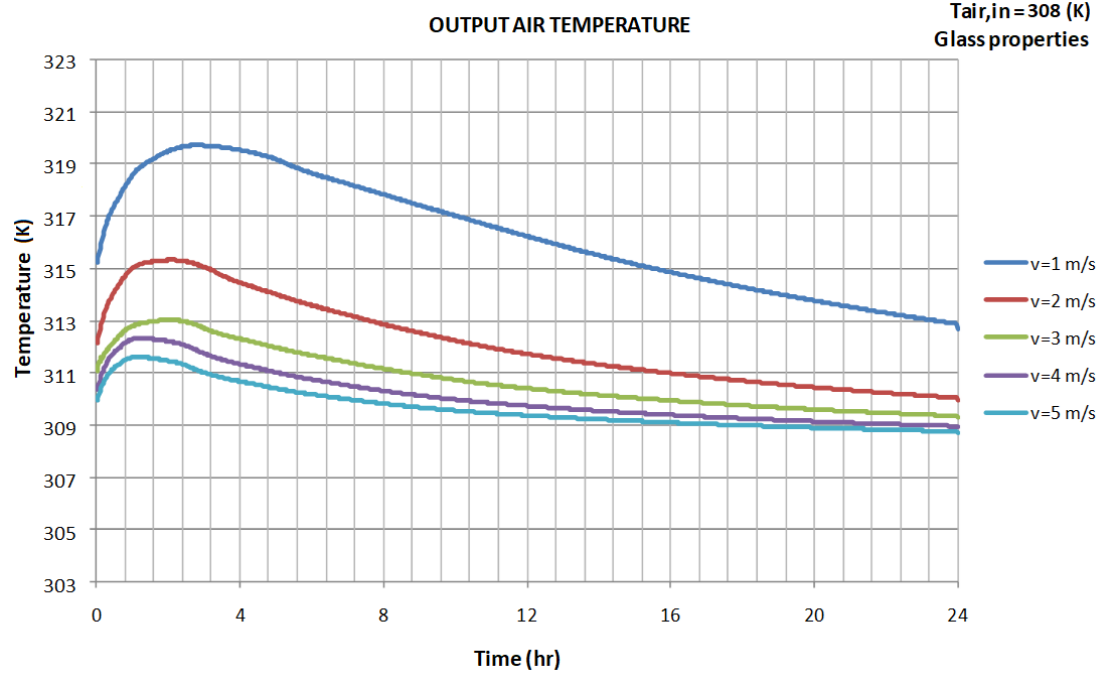
Figure 9. Output air temperature (glass properties).